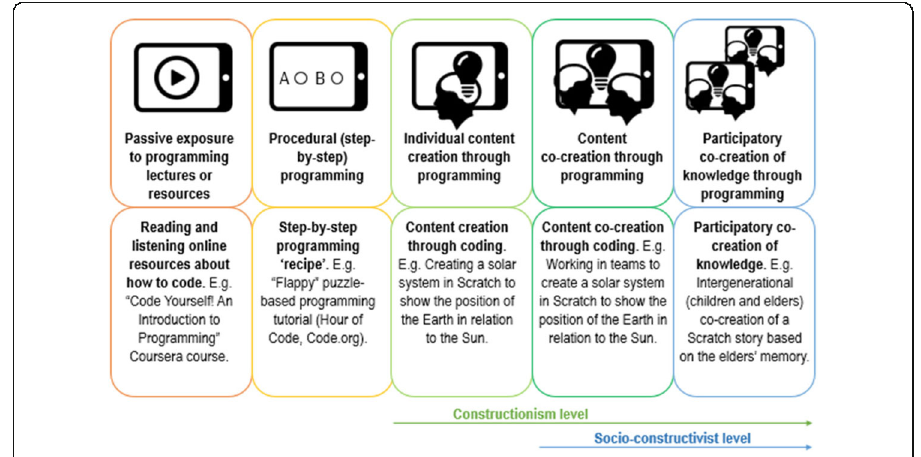
Fig. 1 Five levels of creative engagement in educational programming